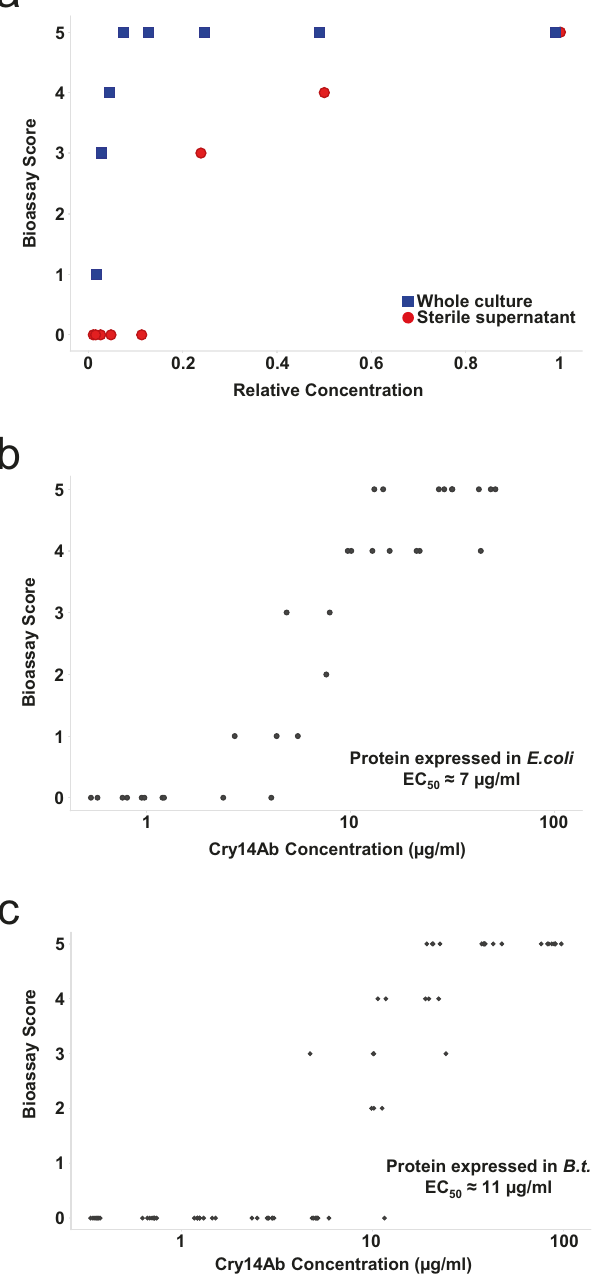
Fig. 3 Effect of Cry14Ab on Caenorhabditis elegans in liquid bioassays. The bioassay visual scoring system is explained in Fig. 1. Graphs were prepared using TIBCO Spot fi re, version 7.10.1. a Whole culture